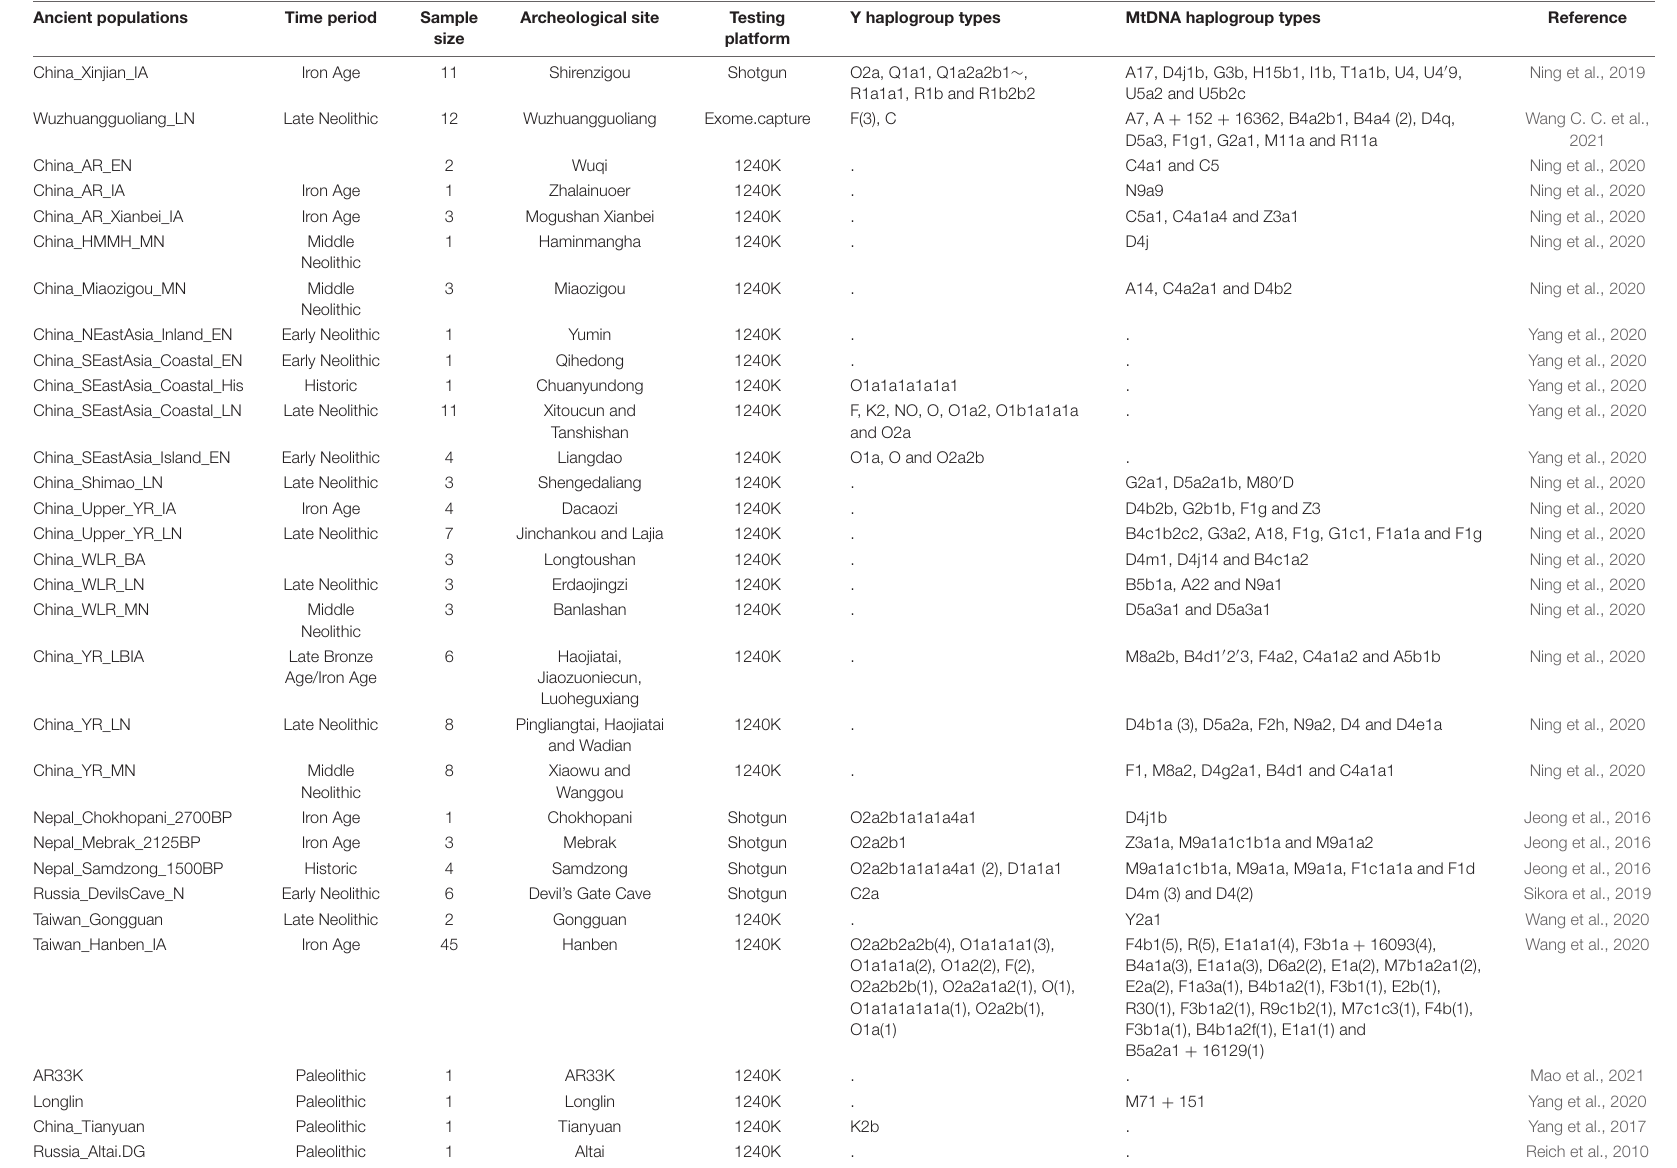
TABLE 1 | The detailed information of included ancient Chinese